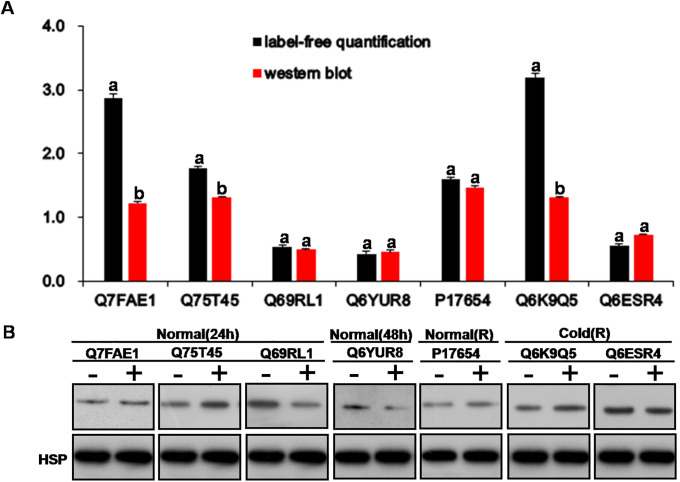
Validation of DEPs.(A) Comparison of fold-change of DEPs obtained by label-free quantification and Western blot analysis. The values on the y-axis indicate fold-change. (B) Western blot analysis of DEPs showing four upregulated proteins, including Q7FAE1 (momilactone A synthase), Q75T45 (RSOsPR10),P17654 (alpha-amylase) and Q6K9Q5 (serine/threonine-protein phosphatase), and three downregulated proteins, including Q69RL1 (GST), Q6YUR8 (CSP1) and Q6ESR4 (DHN1). Four DEPs, including Q7FAE1, Q75T45, Q69RL1, and Q6YUR8, of rice roots grown at 25°C for 24 h and 48 h after the treatment with water and nystose. Three DEPs, including P17654, Q6K9Q5, and Q6ESR4, of rice roots grown at 25°C for 7 d and 4°C for 2 d and then at 25°C for 5 d after the treatment with water and nystose. Normal (24 h) represents rice roots grown at 25°C for 24 h after the treatment with water and nystose. Normal (48 h) represents rice roots grown at 25°C for 24 h after the treatment with water and nystose. Normal (R) represents rice roots grown at 25°C for 7 d after the treatment with water and nystose. Cold (R) represents rice roots grown at 4°C for 2 d and then at 25°C for 5 d after the treatment with water and nystose. “+” indicates soaking of the seeds in 75 mg/L nystose, “-” indicates soaking of the seeds in water.